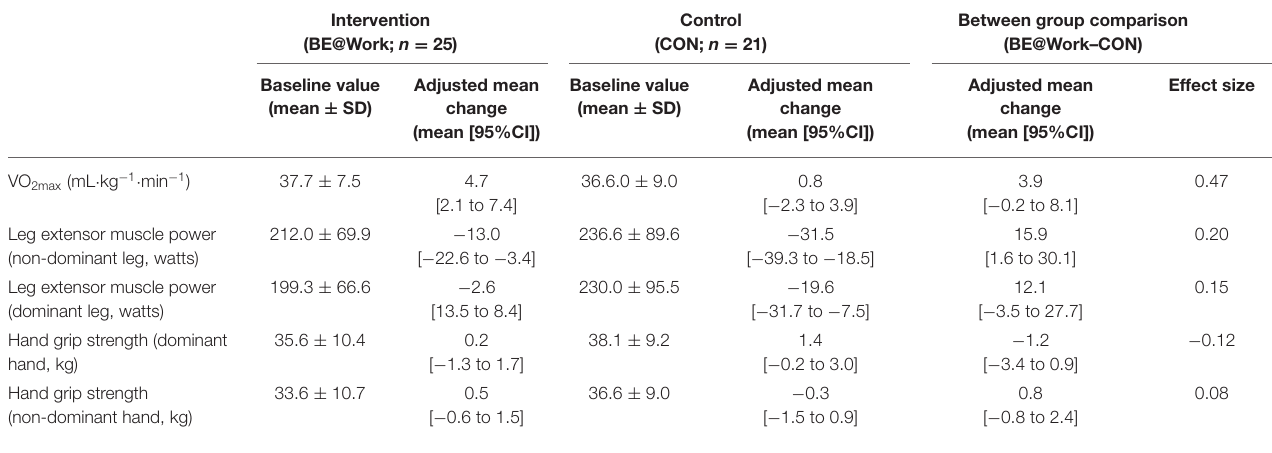
TABLE 4 | Intervention effect on physical fitness